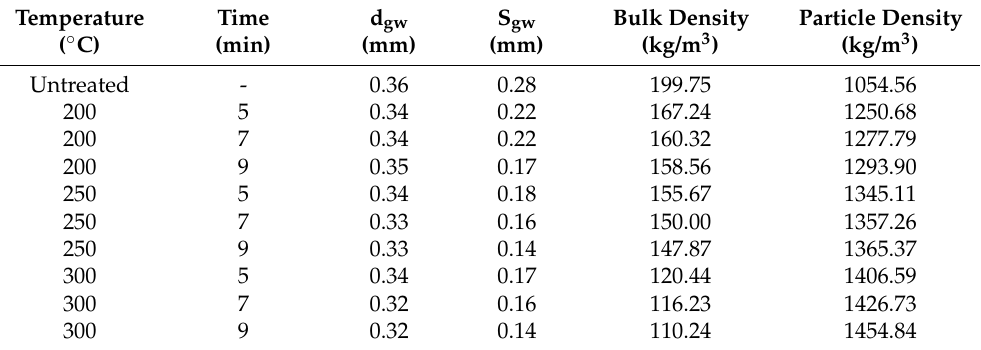
Table 4. Particle size, bulk, and particle density of raw and torrefied WSS at different